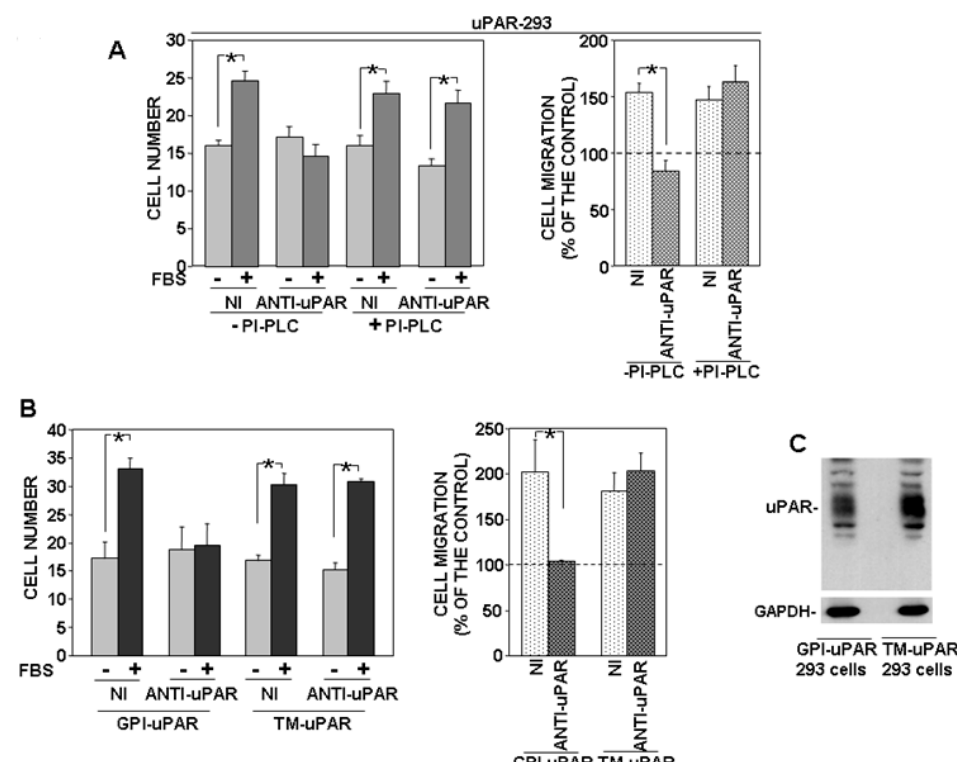
Figure 3. GPI-tail of uPAR mediates its control of cell migration mechanisms. ( A ) uPAR-293 cells were incubated with 1 U/mL of phosphatidylinositol-specific phospholipase C (PI-PLC) or with diluent. Cells were then treated with 5 µg/mL polyclonal anti-uPAR antibody or nonimmune Ig (NI) for 1 h and plated in Boyden chambers to migrate towards 10% fetal bovine serum (FBS). Migrated cells were fixed, stained with hematoxylin, and counted (left graph). Results of migration assays are also expressed as percentage of cells migrated towards serum over the cells migrated without serum; 100% values represent cell migration in the absence of chemoattractants (right graph). The values are the mean ± SD of three experiments performed in triplicate. (*) p ≤ 0.05, as determined by the Student’s t -test. ( B ) HEK-293 cells were transiently transfected with cDNAs of transmembrane chimeric uPAR (TM-uPAR) or full length uPAR (GPI-uPAR) as a control. Transfected cells were incubated with 5 µg/mL polyclonal anti-uPAR antibody or nonimmune Ig (NI) for 1 h and then plated in Boyden chambers and allowed to migrate towards 10% FBS. Migrated cells were fixed, stained with hematoxylin, and counted (left graph). Results of migration assays are also expressed as percentage of cells migrated towards serum over the cells migrated without serum; 100% values represent cell migration in the absence of chemoattractants (right graph). The values are the mean ± SD of three experiments performed in triplicate. (*) p ≤ 0.05, as determined by the Student’s t -test. ( C ): GPI-uPAR and TM-uPAR expression in transiently transfected cells was assessed by Western blot analysis with the same anti-uPAR polyclonal antibody used in cell migration assays; membranes were then reprobed with an anti-GAPDH mouse antibody for loading control. The effect of MCD on the partition of uPAR to lipid rafts was assessed by loading lysates of MCD-treated or untreated cells on sucrose gradients, in which, after ultracentrifugation, proteins associated with lipid rafts tend to float to the top fractions of the gradient. Fractions harvested after ultracentrifugation were analyzed by Western blot with specific antibodies. Results showed that uPAR associated with lipid rafts in MCD-untreated cells, as expected, in both PC3 and uPAR-293 cells; caveolin was used as a control of lipid raft-associated protein and tubulin as marker for non- raft fractions (Figure 4D, left panels). In MCD-treated cells, uPAR and caveolin were only recovered